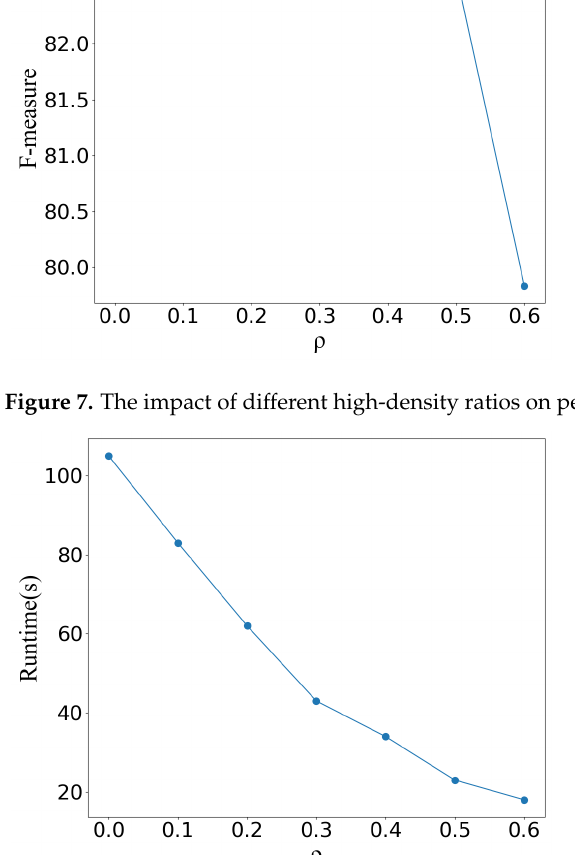
Figure 8. The impact of different high-density ratios on